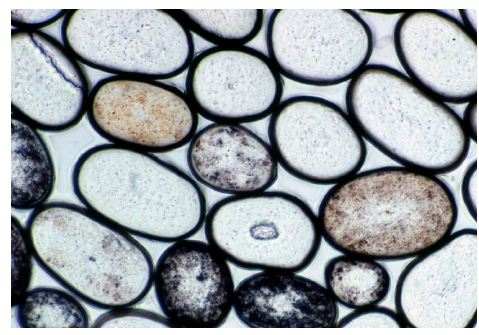
Figure 22. Cross-sections of hair dyed with melanin precursor.